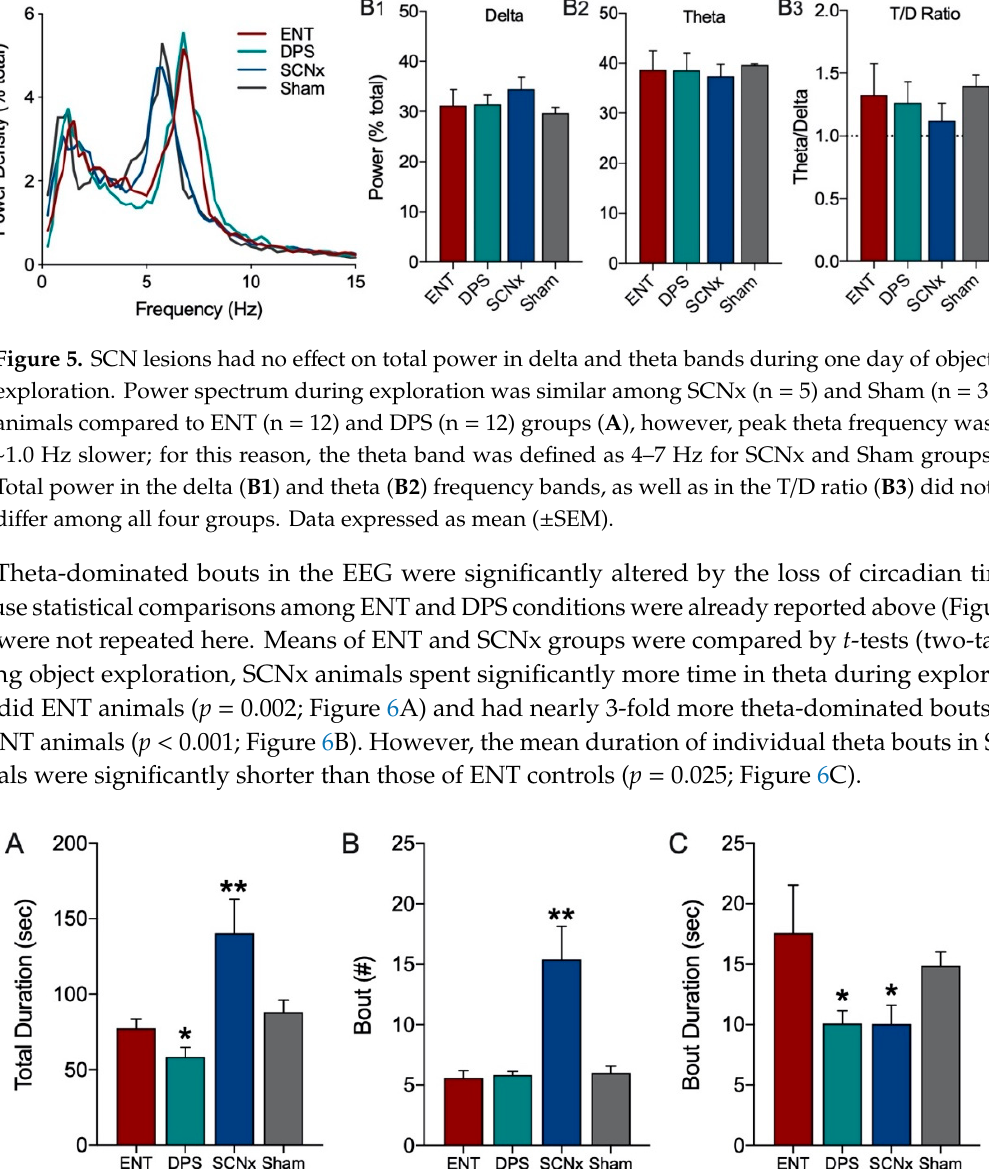
Figure 6. Theta dominance in the EEG during object exploration was substantially increased by SCN lesions. The total duration of time spent with an object ( A ) and the number of theta-dominated bouts ( B ) was significantly higher in SCNx compared to ENT animals. By contrast the duration of individual theta bouts ( C ) was significantly lower. Data from Sham animals are shown for comparison. Data expressed as mean (± SEM). * indicates significant differences; see text for p values. ** p < 0.001.